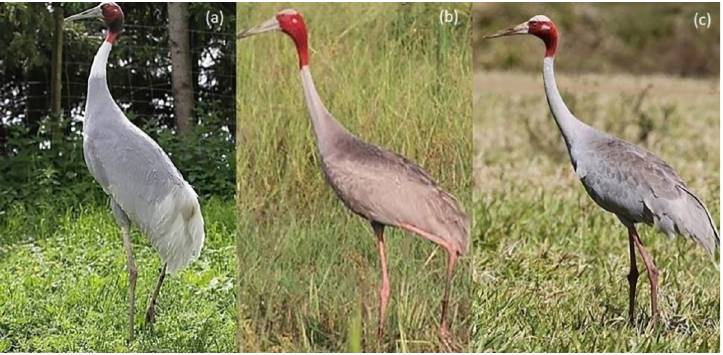
Fig 2. Extant Sarus Crane subspecies. (a) antigone South Asia (captive bird); (b) sharpii Myanmar and Indochina (wild Cambodian bird); (c) gillae Australia (wild Northeast Queensland bird). [Photographs T, Nevard (a) and (c); Robert van Zalinge